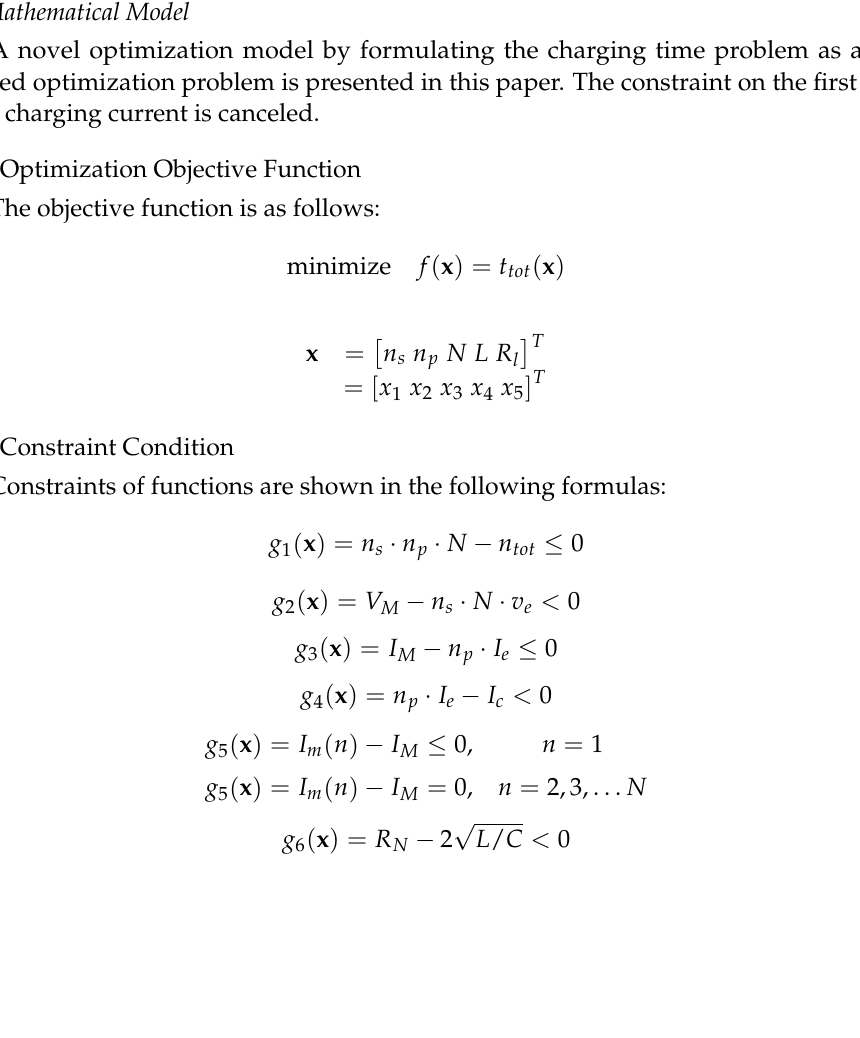
Table 2. The states of electrical parameters in the hybrid energy storage circuit before the optimization of the Enumeration algorithm. Parameter Description State C the capacitance of pulse capacitor known V M required charging voltage known v e the open-circuit voltage of each battery cell known r e the internal resistance of each battery cell known I e the maximum continuous discharge current of each battery cell known I M required maximum charging current known I c maximum turn-off current of the main switch K c known n s number of series batteries in each battery pack unknown n p number of parallel batteries in each battery pack unknown N total number of battery packs unknown n tot = Nn s n p total number of battery cells known V E = n s v e the open-circuit voltage of each battery pack unknown r n = n s r e / n p the internal resistance of each battery pack unknown L the inductance of the current-limiting inductor unknown R l the resistance of the current-limiting inductor